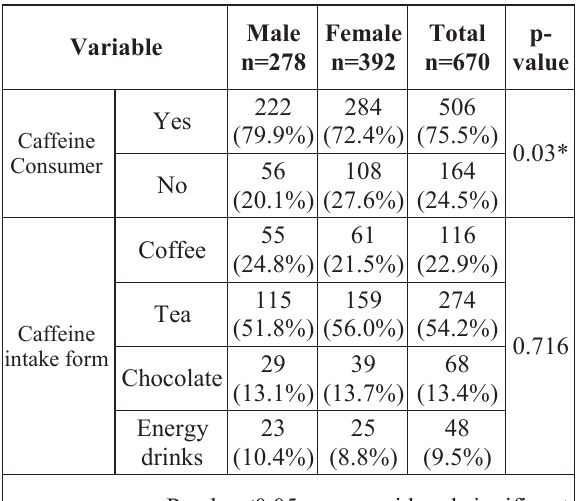
Table-2: Perception of effects of caffeine in consumers Perception of effects of caffeine in two categories were asked from non-consumers of caffeine. These categories were anxiety/negative physical effects and sleep